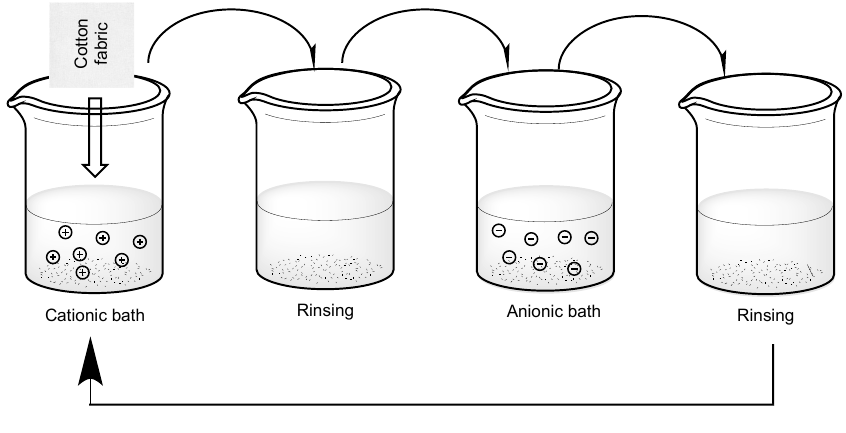
Figure 3. Scheme of the layer-by-layer (LbL) dipping process (first two depositions) carried out on a cotton fabric, using two polyelectrolytes/suspensions that are oppositely electrically charged.